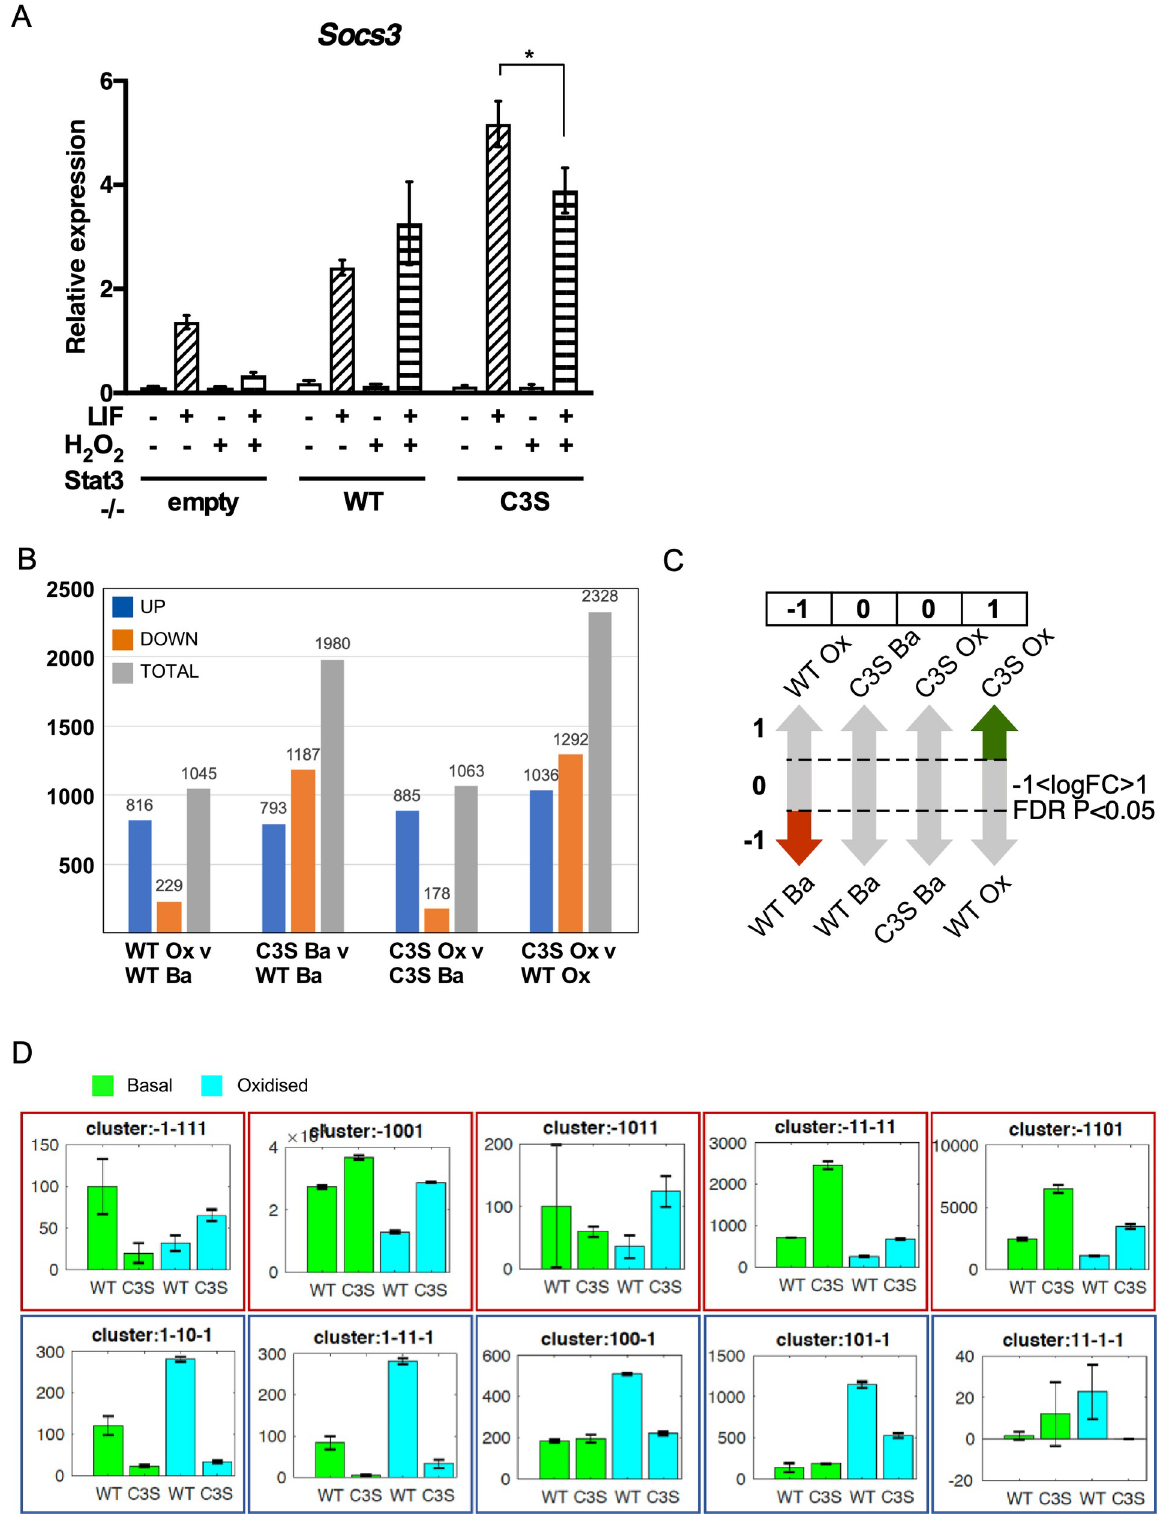
Fig 2. Differential -/-WT and -/-C3S expression profiling reveals genes acutely responsive to Stat3 oxidation. A) RNA isolated from MEFs untreated (-), treated with 10 ng ml -1 LIF for 30 mins and/or 100 μ M H 2 O 2 for 1 h (+) was enriched for mRNA and analysed for Socs3 and Hbs1l